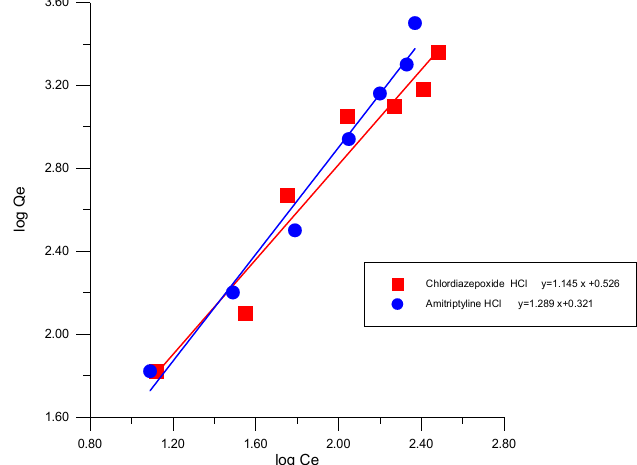
Figure 2: Freundlich lines of amitriptyline HCl and chlordiazepoxide HCl on Bentonite at 37.5 C